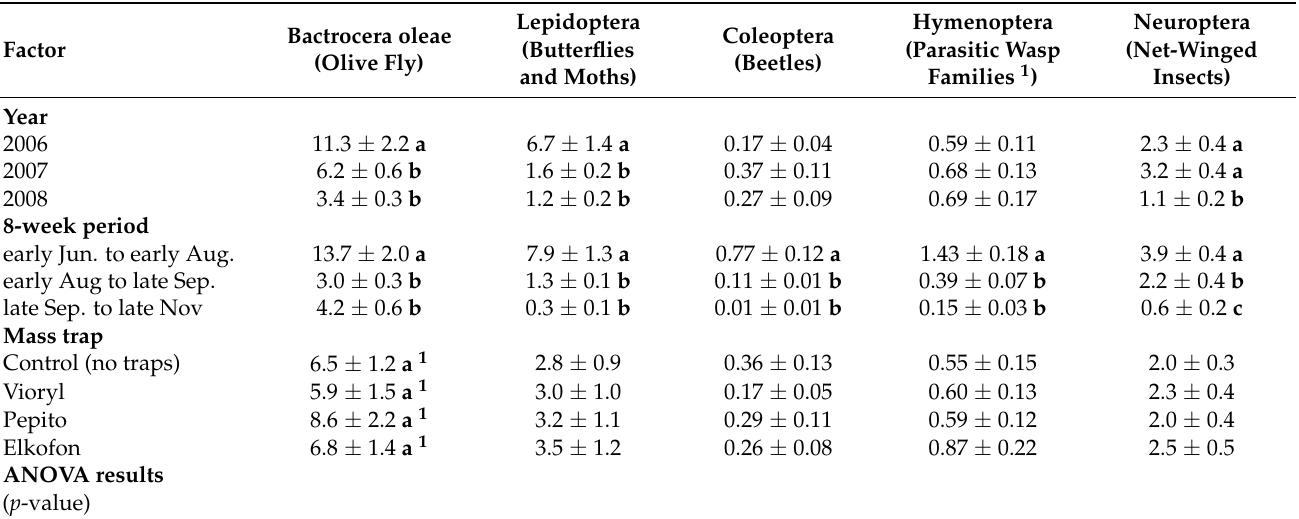
Table 6. Effect of, and interactions between, (a) year (2006, 2007, 2008), (b) 8-week period (early June trapping system (on the activity (insects caught in McPhail monitoring traps) of major invertebrate groups/orders after mass-trapping systems were placed into table olive